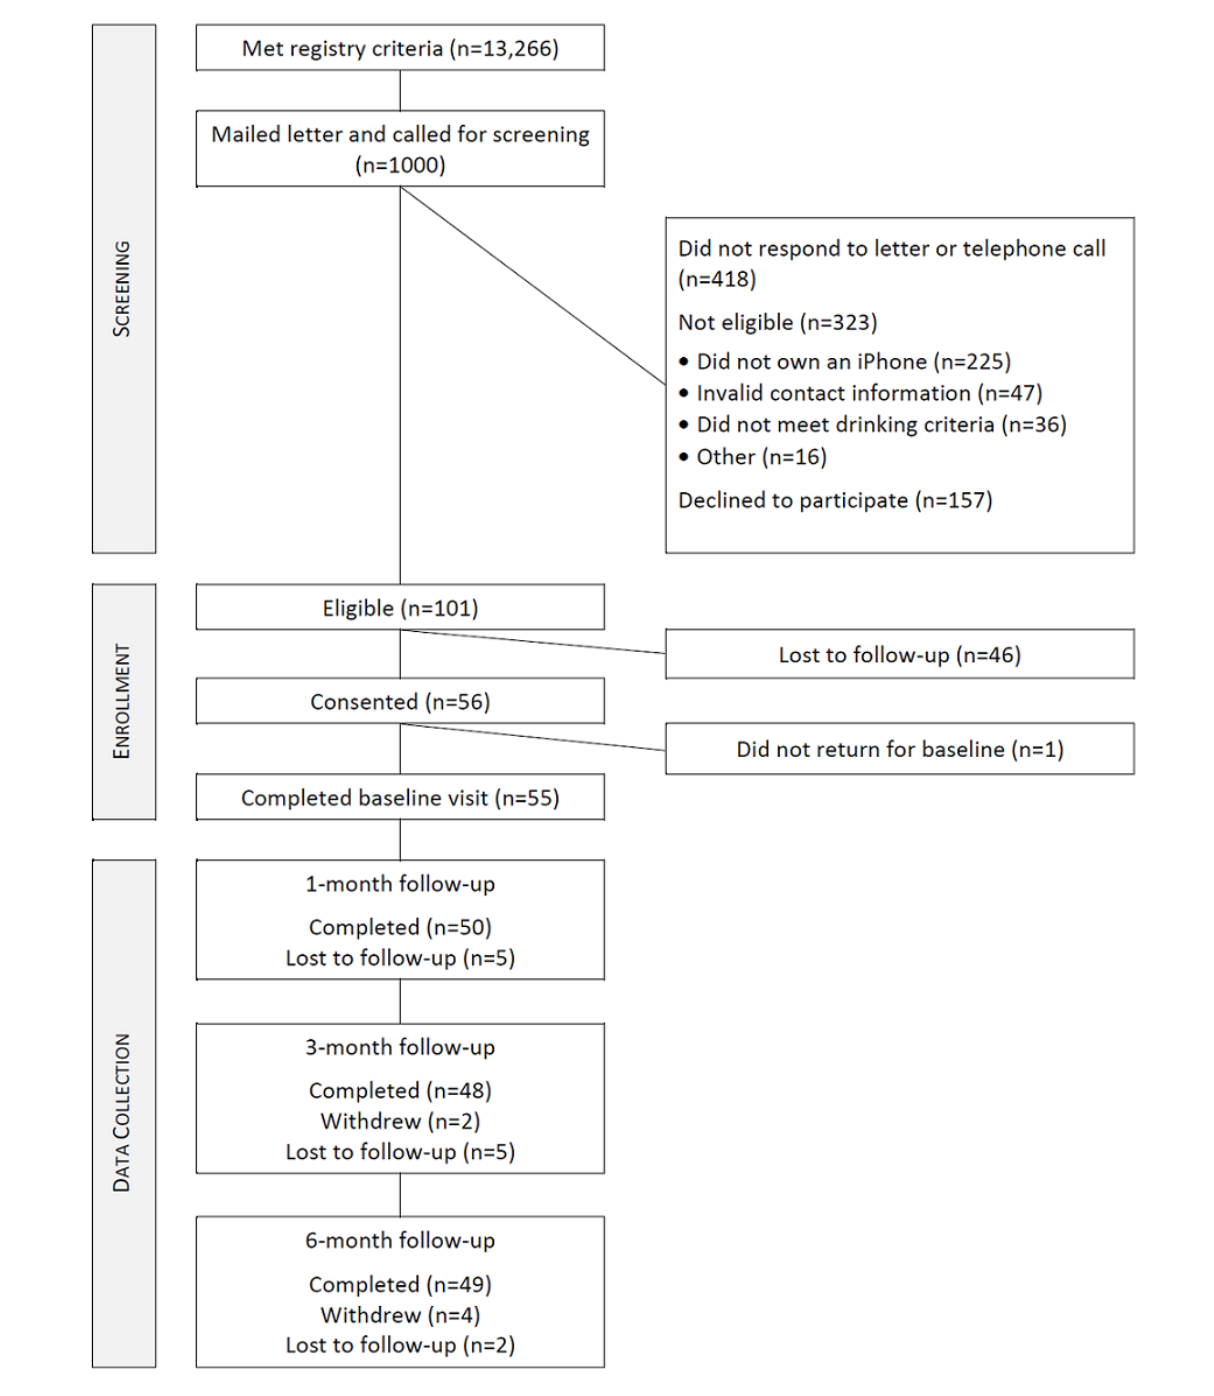
Figure 1. CONSORT